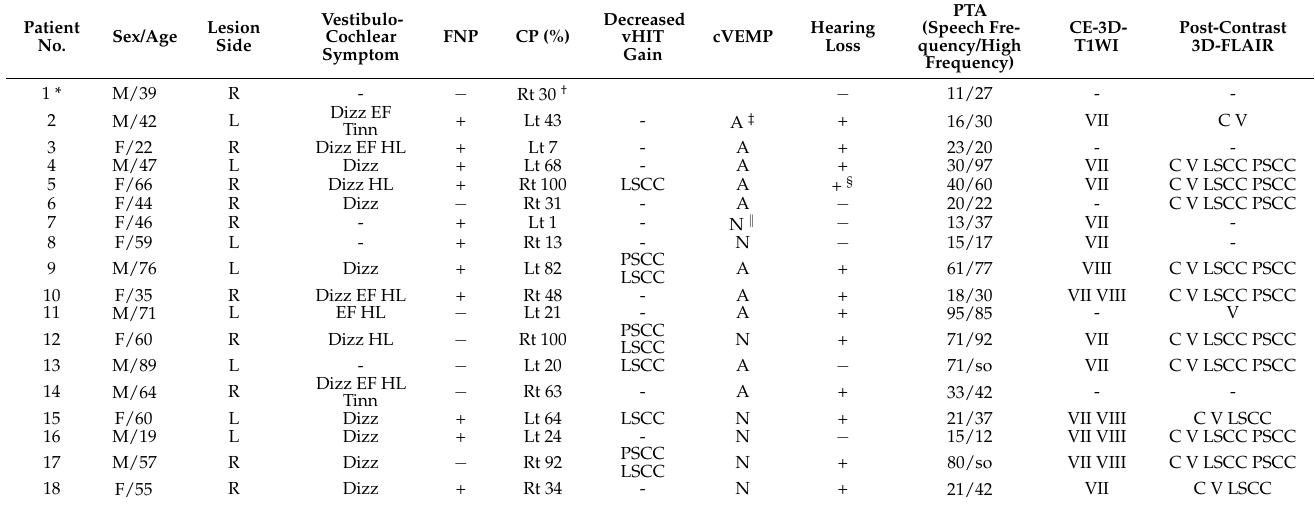
Table 1. Clinical features and MRI findings of patients with Ramsay Hunt syndrome ( n =